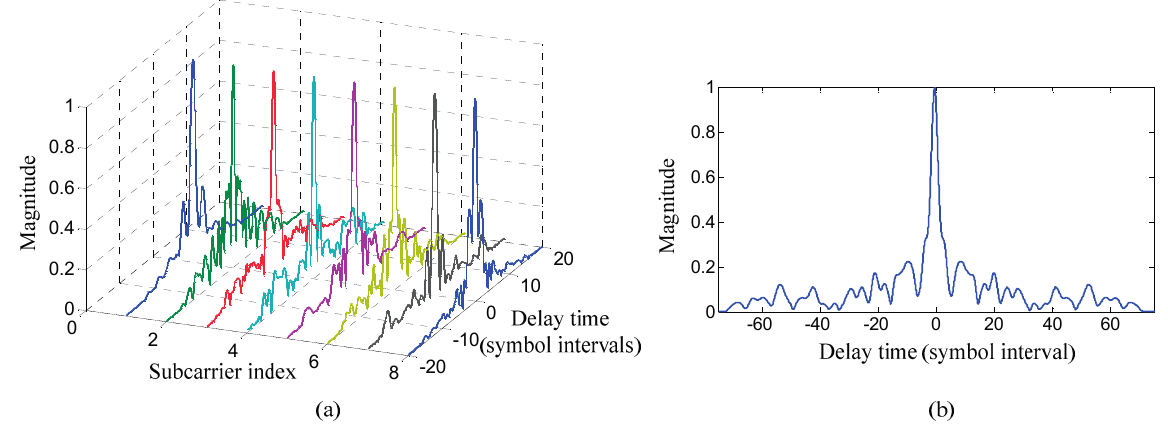
Figure 8. Comparison of each estimated composite channel from the transmit filter to the matched filter for the TR process between two communication methods in the experiment: ( a ) the proposed method; and ( b ) the TR acoustic communication using SC